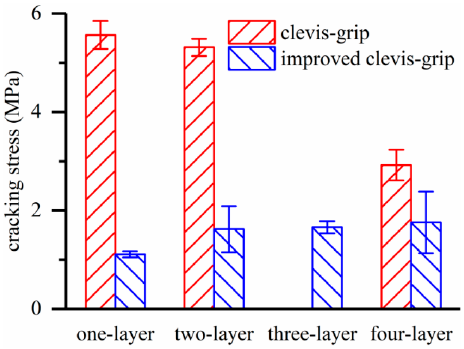
Figure 9. Effect of test setups on cracking stress.